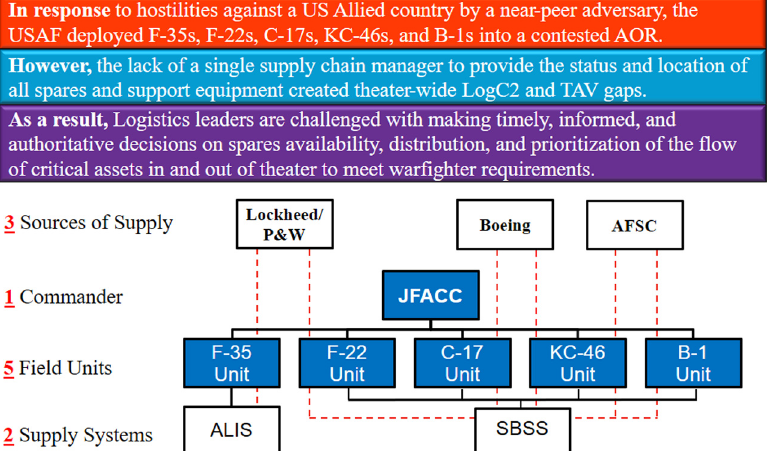
Figure 13. The JFACC A4 ’ s